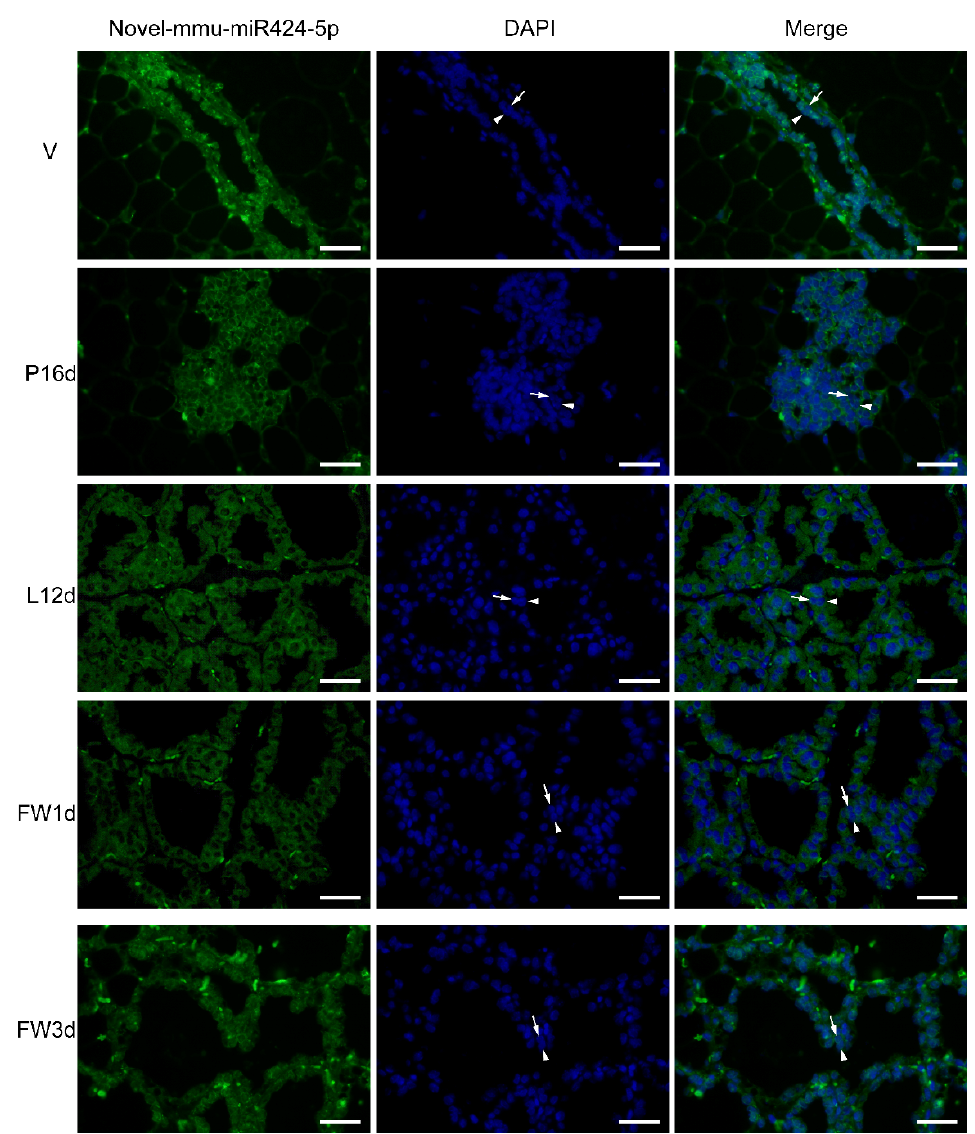
Figure 5. FISH analysis of novel-mmu-miR424-5p at distinct stages of mammary gland development. In the luminal and basal epithelial cell layers, the novel-mmu-miR424-5p was abundantly expressed. The luminal cell is shown by the arrow without a tail, whereas the basal cell is indicated by the arrow with a tail. Scale bars = 20 μ m.